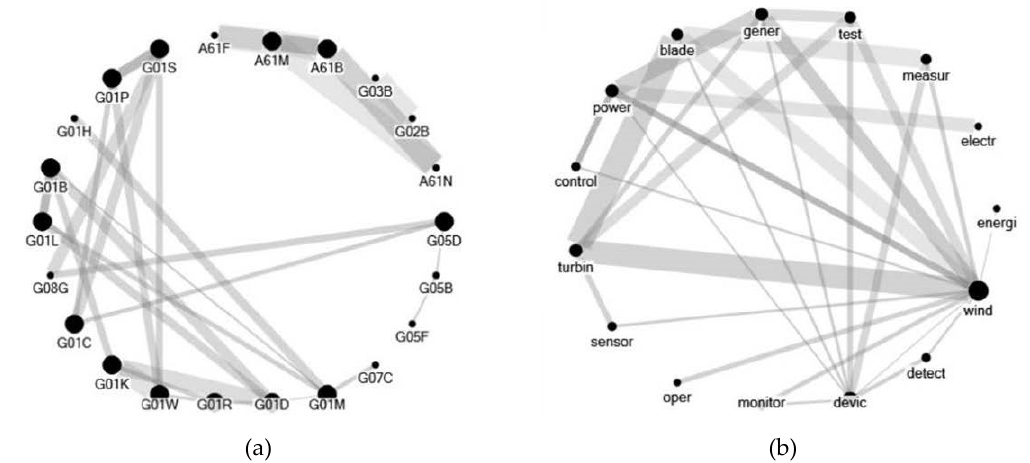
Figure 5. Instruments network graph to visualize ARM. (a) Instruments IPC Network; (b) Instruments Key Terms Network.